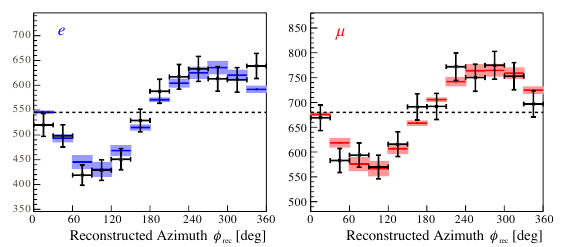
Figure 5. The azimuthal distributions of a subselection of e -like (left) and µ -like (right) events, from the Super-K data (points